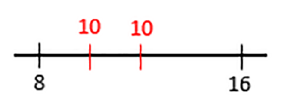
Figure 1. Example of trial from the Number Line Knowledge